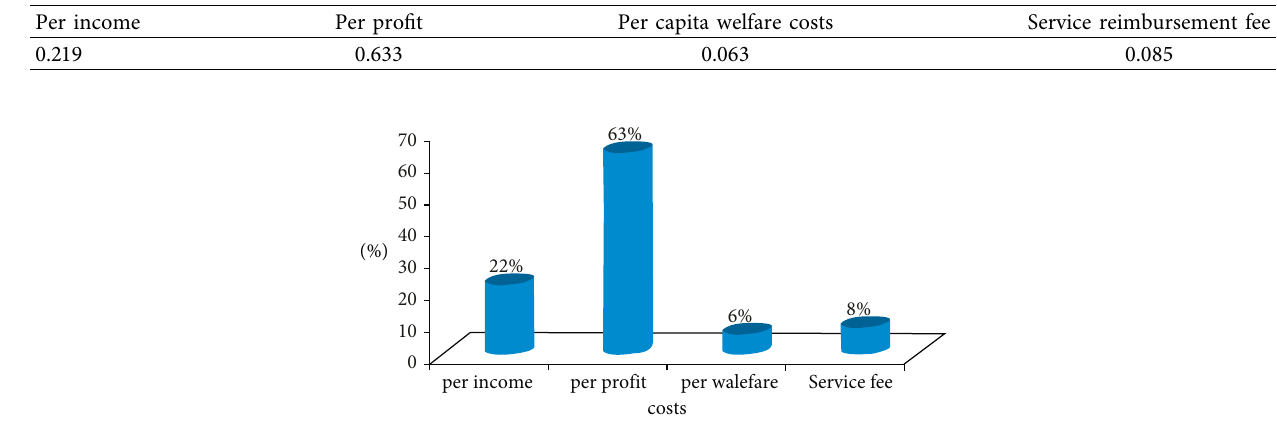
Table 4: Weight of criteria in financial view.